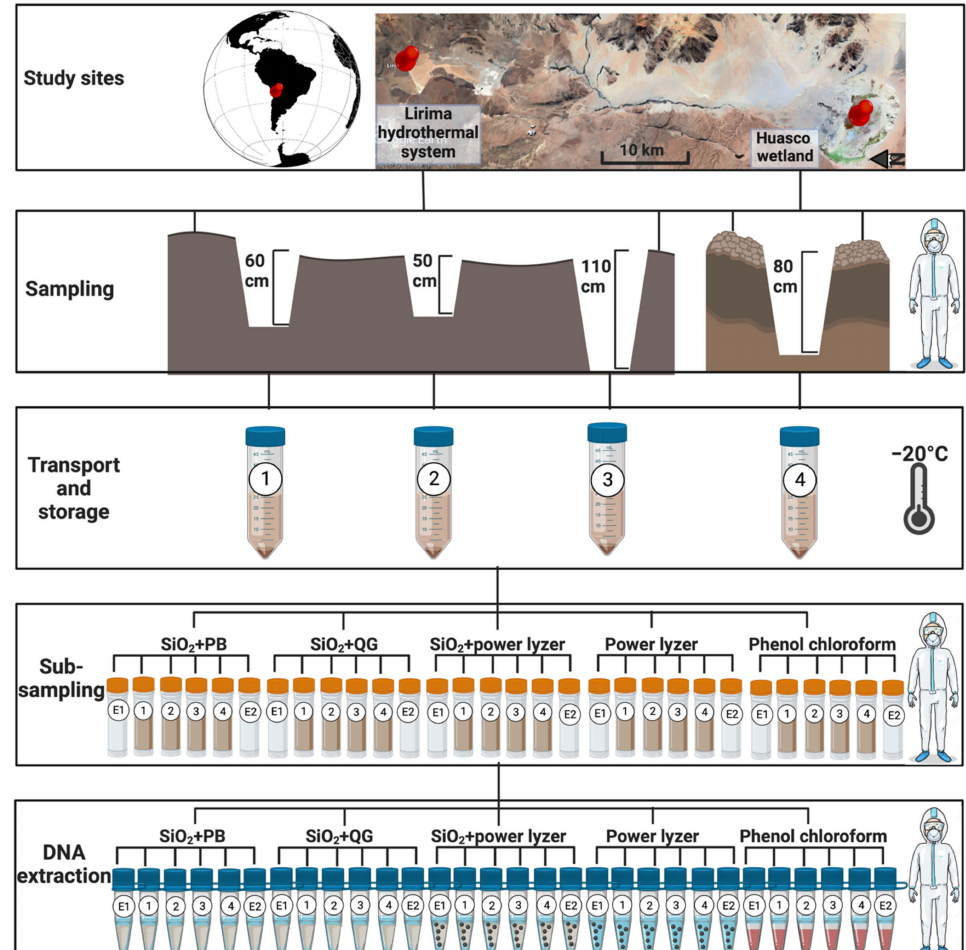
Figure 1. Diagram depicting procedures from sampling collection to DNA extraction. E1: Extraction blank control 1 (EBC1); 1: Sample 1; 2: Sample 2; 3: Sample 3; 4: Sample 4; and E2: Extraction blank control 2 (EBC2). Study sites: Satellite image with the location of Lirima hydrothermal system and Huasco wetland marked. Sampling: Sample 1 was taken at 60 cm depth, Sample 2 at 50 cm, Sample 3 at 110 cm and Sample 4 at 80 cm. Transport and storage: samples were transferred from study site to the lab in liquid nitrogen and then storage at − 20 ◦ C. Sub-sampling: The four samples were sub- sampled in a specialized aDNA facility, and two extraction blanks were created for every extraction batch. DNA extraction: sub-samples and extraction blanks were extracted using five different extraction methods (SiO 2 + PB, SiO 2 + QG, SiO 2 + PowerLyzer, PowerLyzer and